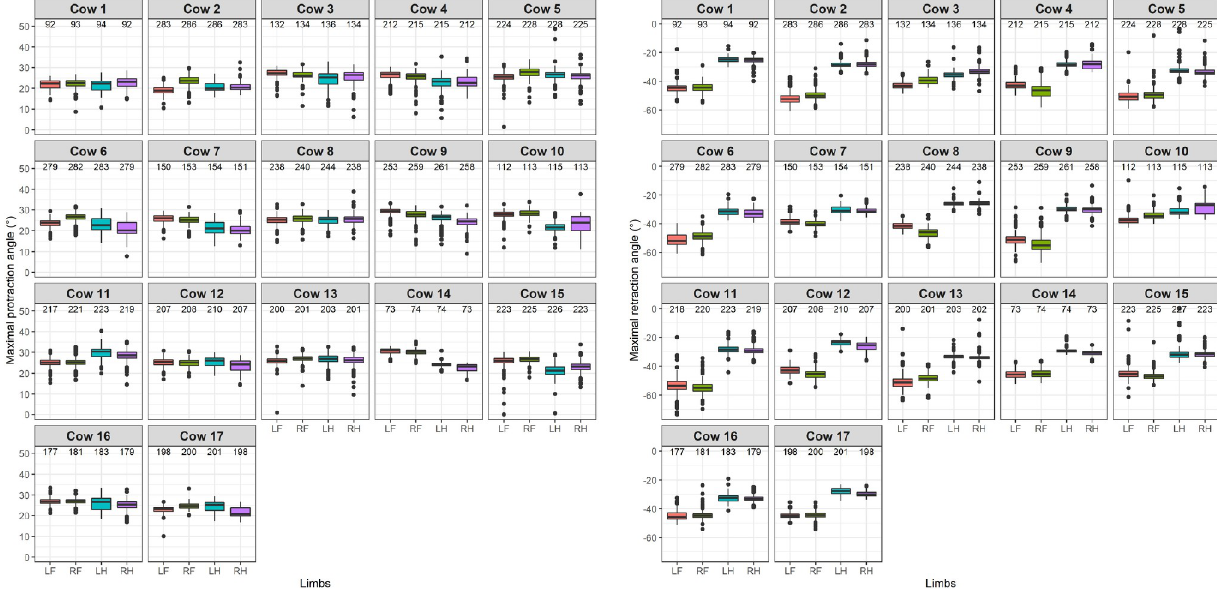
Fig 6. Distribution of distal limb maximal protraction (left panel) and maximal retraction (right panel) angles in degrees for every cow and limb separately. In red: LF, green: RF, blue: LH and purple: RH. The number of selected strides per limb is shown above the boxes. The spacing of the boxplot shows the range between the first and third quartile, the median is indicated with the black line, the whiskers show the range of the maxima and minima and the outliers are indicated with dots.